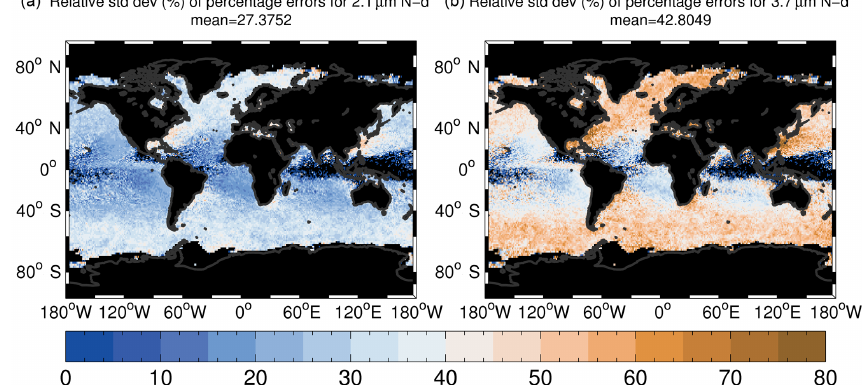
Figure 6. As for Fig. 5 except showing the relative (as a percentage) standard deviation of the percentage N d bias over time, i.e. σ %bias /